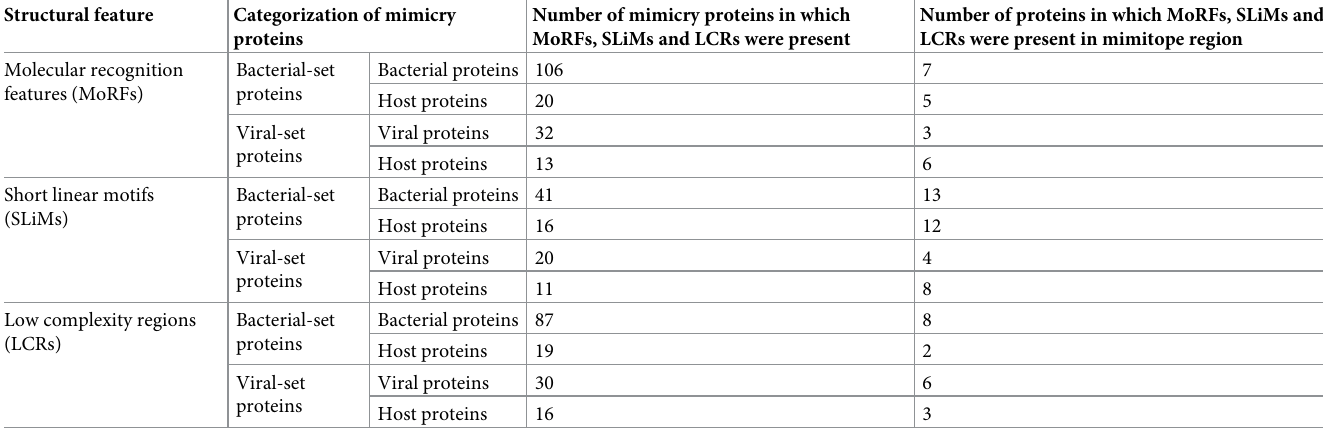
Table 2. Distribution of MoRFs, SLiMs and LCRs in the mimicry proteins and mimitopes of bacteria, viruses and hosts. Structural